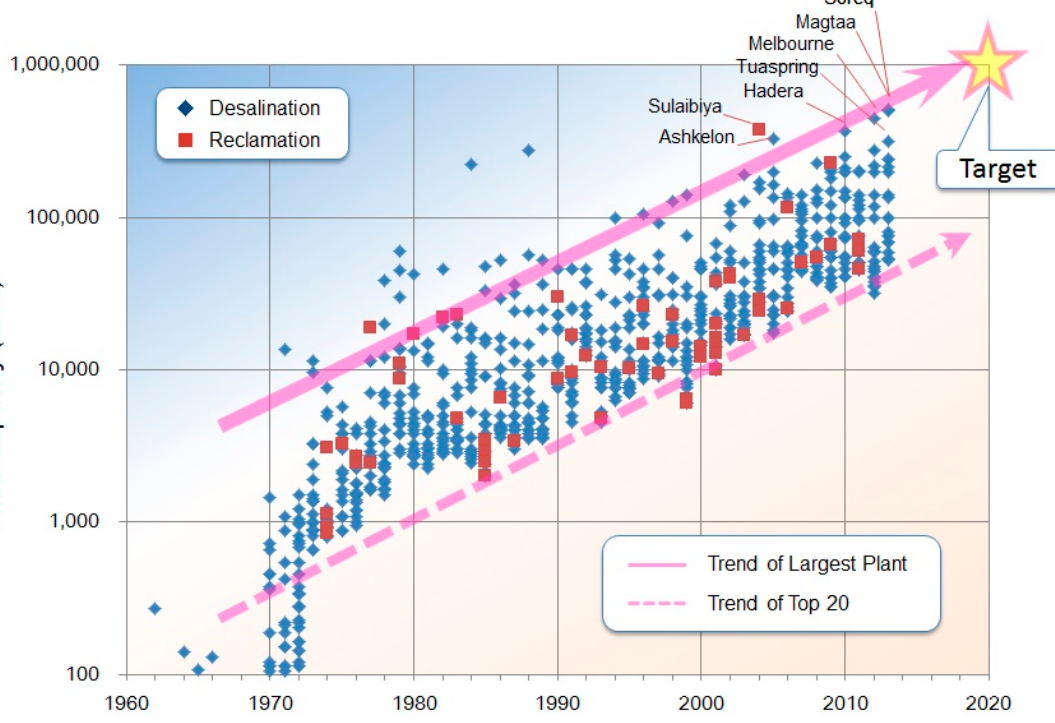
Figure 1. Change in RO (Reverse Osmosis) plant size of desalination and reclamation.